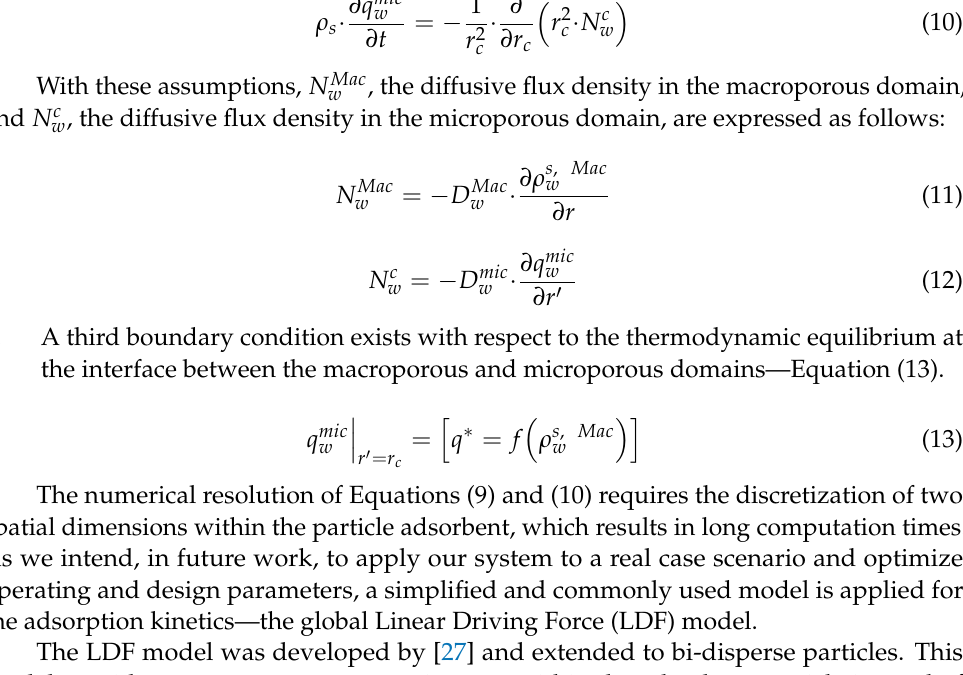
A third boundary condition exists with respect to the thermodynamic equilibrium at the interface between the macroporous and microporous domains—Equation